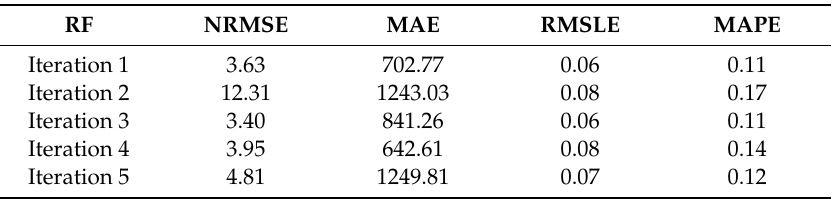
Table 2. Performance assessment of the RF